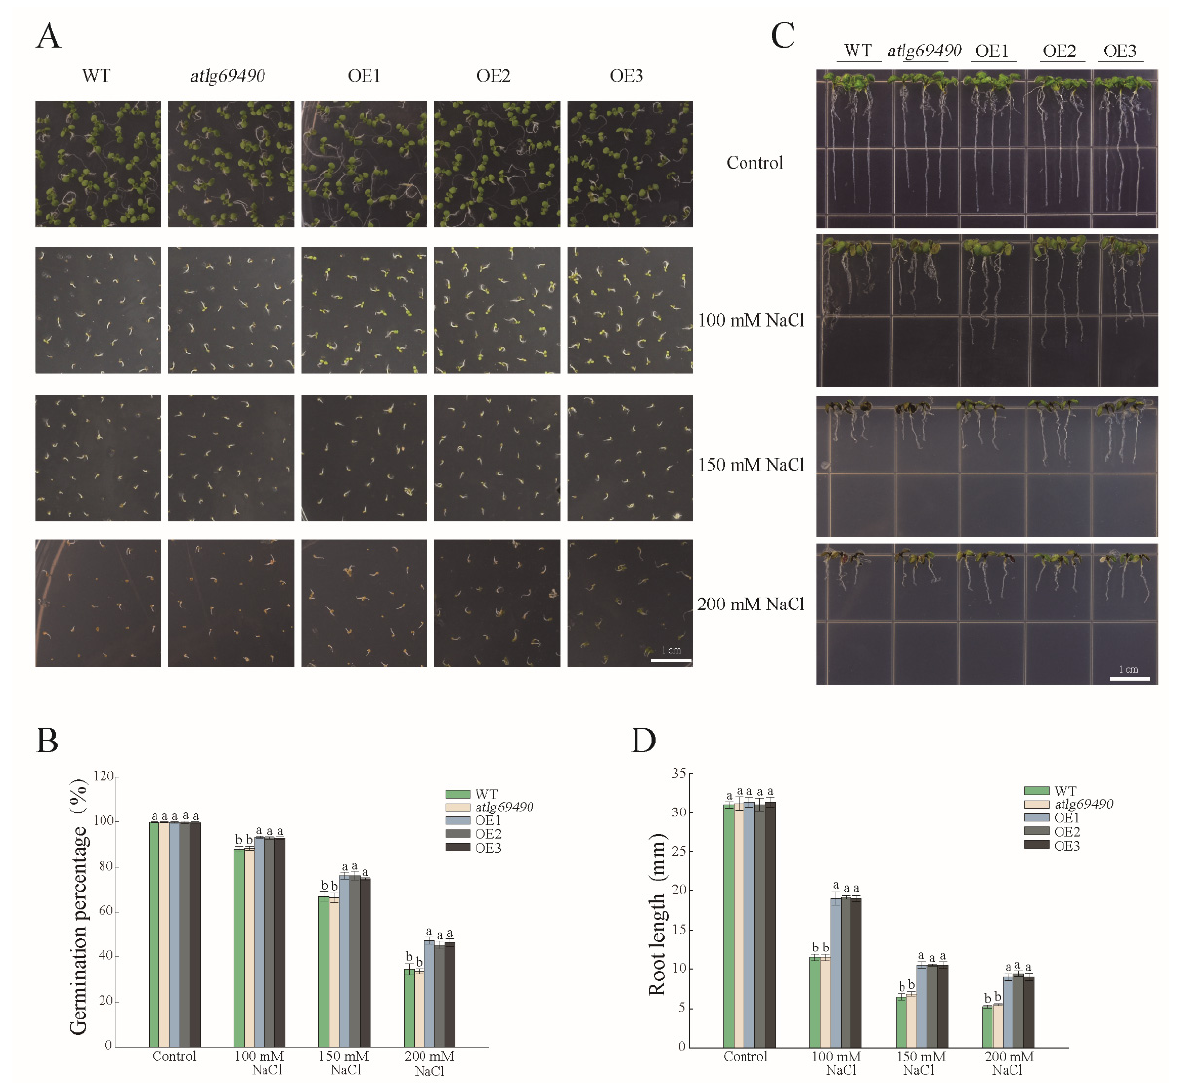
Figure 5. Overexpression of PwNAC38 significantly improved salt tolerance in seed germination and root elongation. ( A , B ) Statistics of germination percentage after salt treatment. ( C , D ) Statistics of seedling root length after salt treatment. The significantly different mean values at p ≤ 0.05 were labeled by different letters.